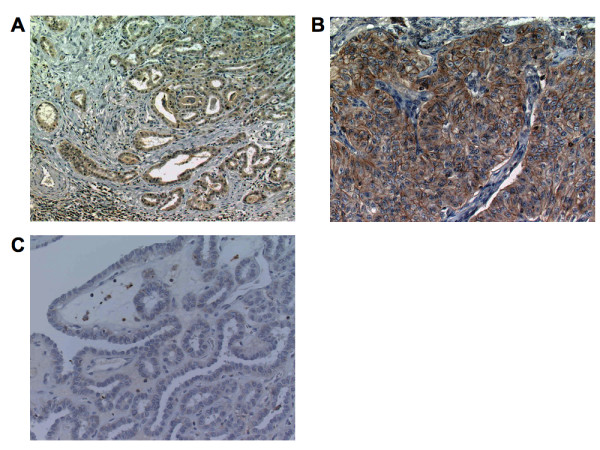
CXCR4 expression in human papillary thyroid carcinoma tissue. (A) immunohistochemical localization of CXCR4 protein was cytoplasmic. (B) In some cases carcinoma cells showed positive staining in the membrane. (C) In the tumor in which CXCR4 immunodetection are unreactive, staining for CXCR4 occurred in inflammatory cells.